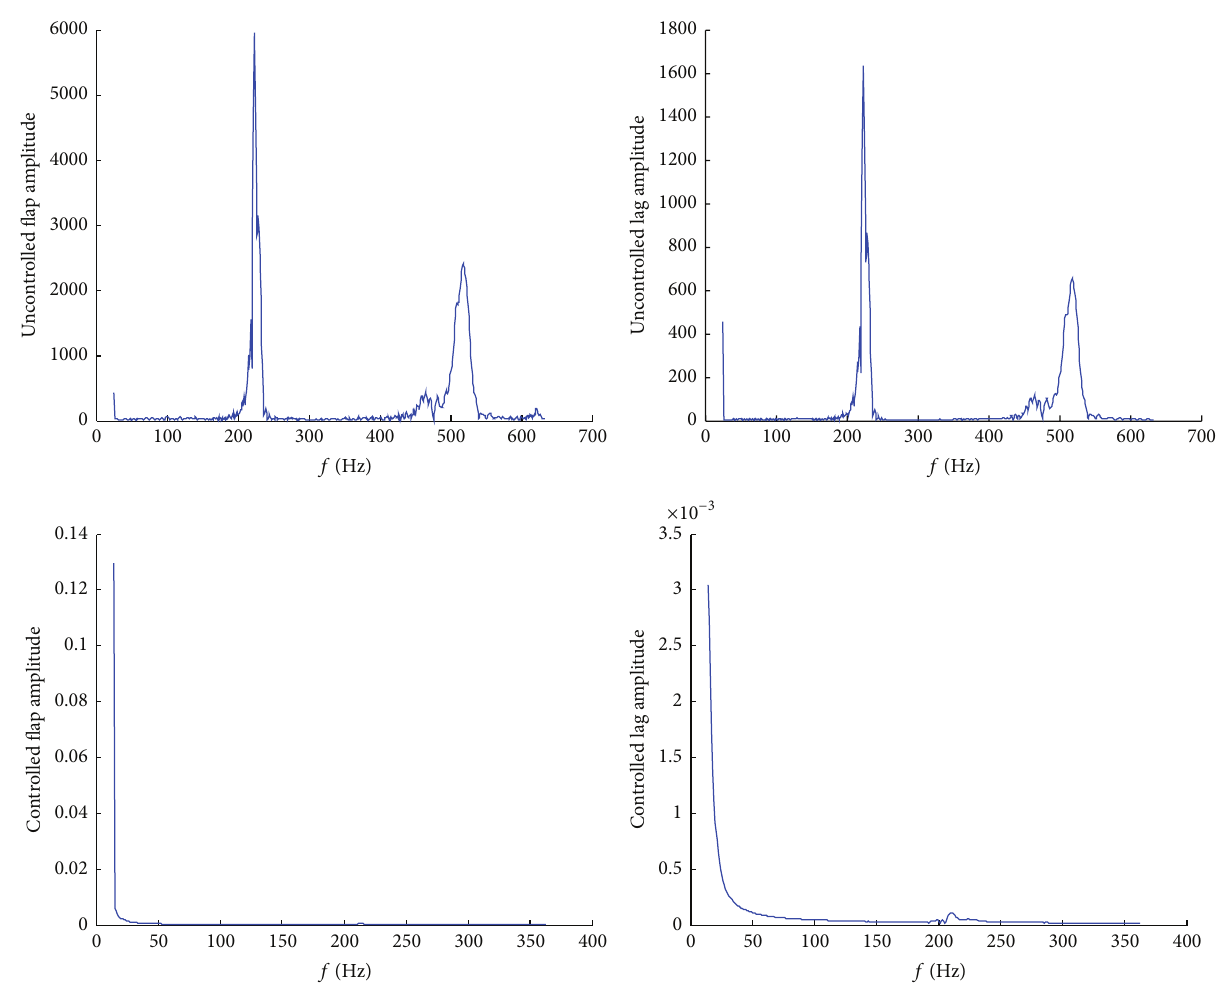
Figure 11: Flap/lag frequency spectrum analysis based on uncontrolled responses and controlled responses,